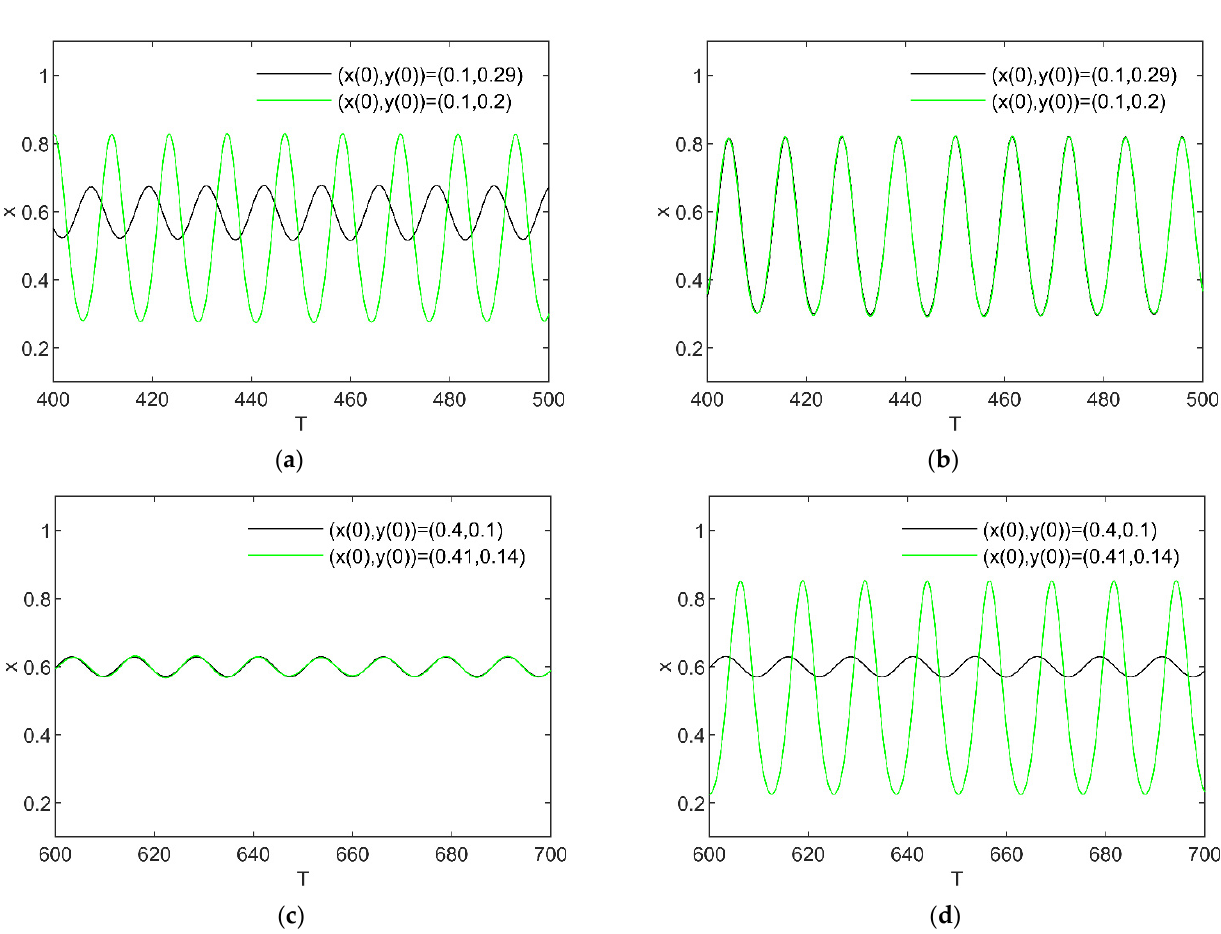
Figure 4. Variation in the amplitude of the intra-well periodic solution with excitation: ( a ) amplitude of the periodic solution vs. ω ; ( b ) amplitude of the periodic solution vs. f 0 .